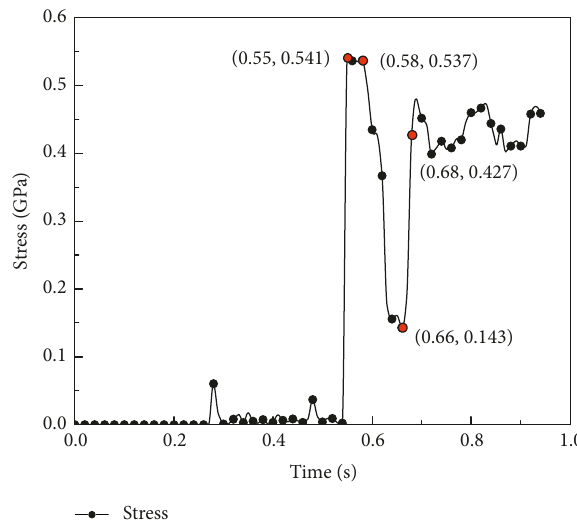
Figure 17: Relationship between impact force and penetration depth.